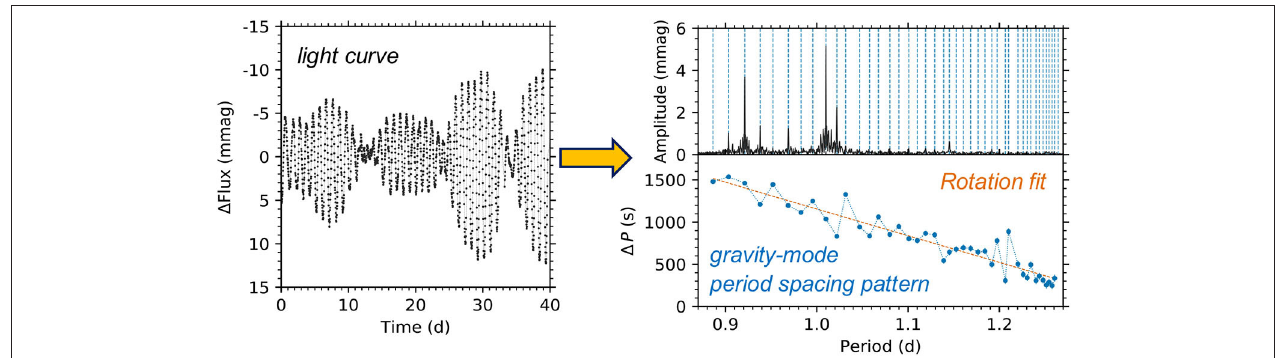
FIGURE 2 | Schematic of the methodology of constraining interior rotation using g modes. (Left) Light curve of the Slowly Pulsating B (SPB) star KIC 3459297 pulsating in low-frequency g modes (cf. Pápics et al., 2017). (Right) Amplitude spectrum and period-spacing pattern of the prograde g-mode pulsations in the light curve are shown as the top and bottom panels, respectively. Pápics et al. (2017) determined f rot KIC 3459297.